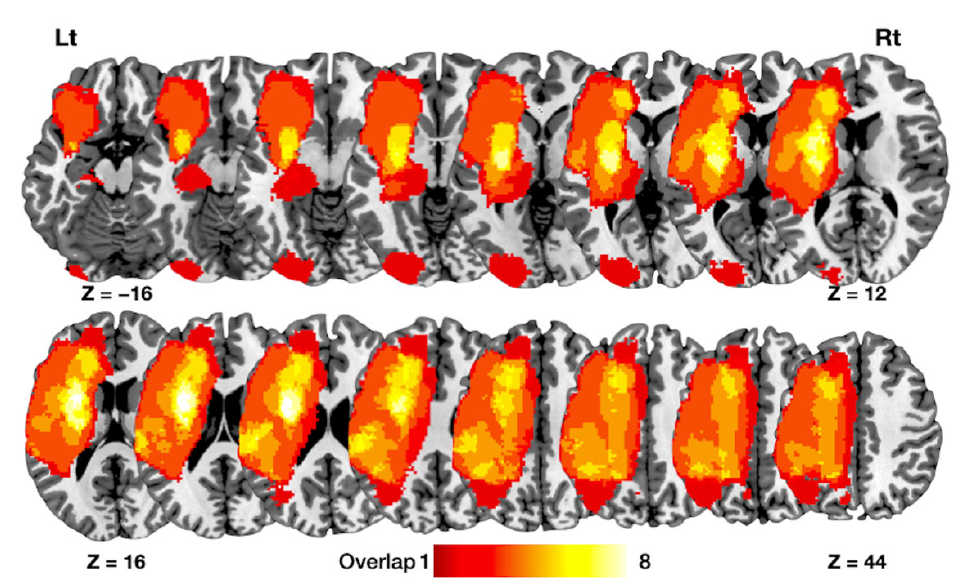
Figure 2. Lesion overlapping maps. Overlay map showing the lesion location in each of the patients 20 included in the study. A T1-weighted map was used to demarcate the lesion corresponding to each patient. The color scale indicates the degree of lesion overlap between patients, with the maximum overlay corresponding to eight patients. Rt = right hemisphere. Lt = left hemisphere. z = z -axis in Montreal Neurological Institute space.